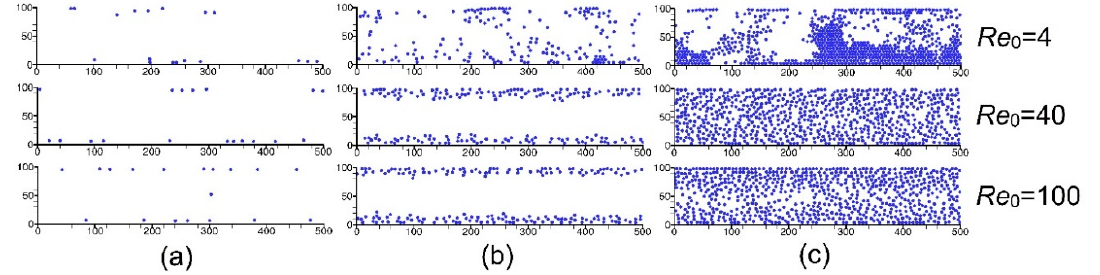
Figure 15. Snapshots of the particle positions with di ff erent particle concentrations, ( a ) φ = 1%, ( b ) φ = 10%, ( c ) φ = 40%. The particle diameter is d p = 6 and all the snapshots are captured at the steady state.